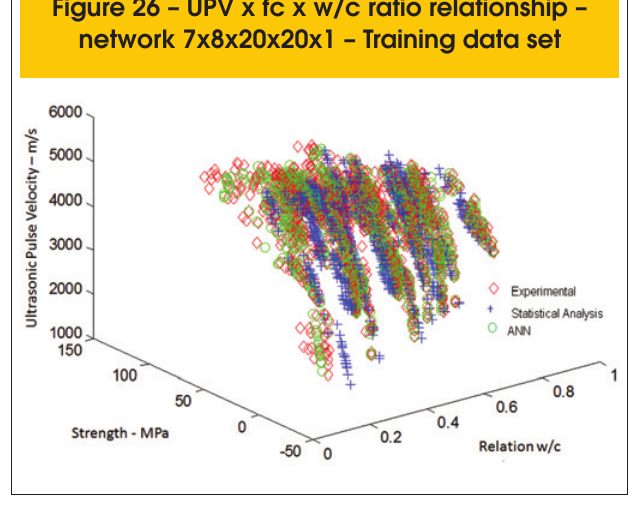
Figure 27 – UPV x fc x w/c ratio relationship – network 7x8x20x20x1 – Test data